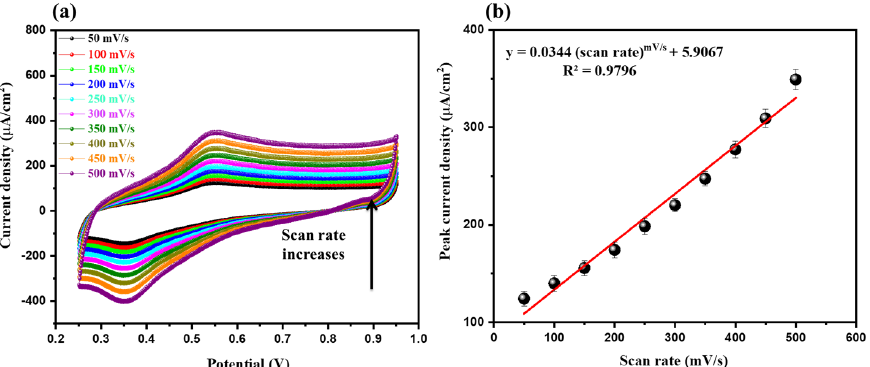
Figure 6. CV patterns ( a ) of S@rGO/GCE in a fixed concentration of acetaminophen (91 µM) in 0.1 M PBS (pH = 7.0) at various applied scan rates (50–500 mV/s). Calibration curve between peak current density responses versus scan rate ( b ).